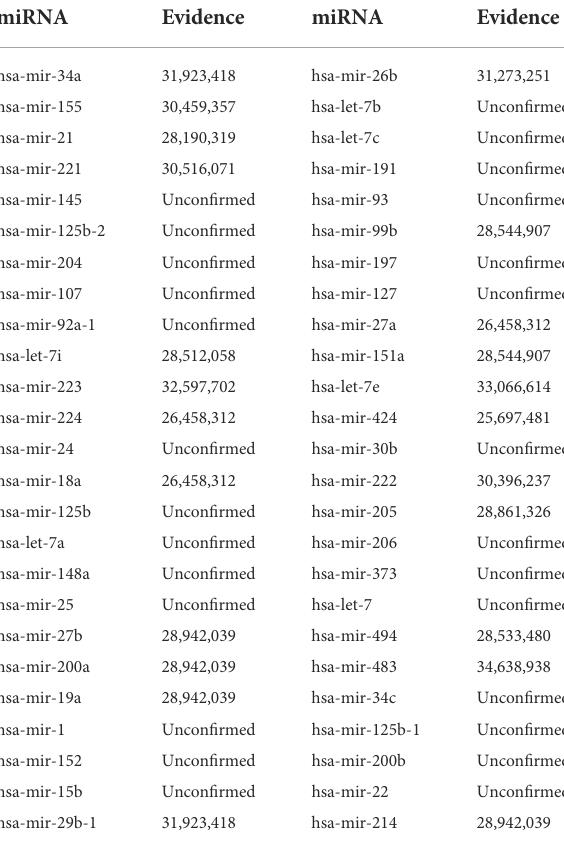
TABLE7Validationofthetop50predictedmiRNAsrelated toImatinib